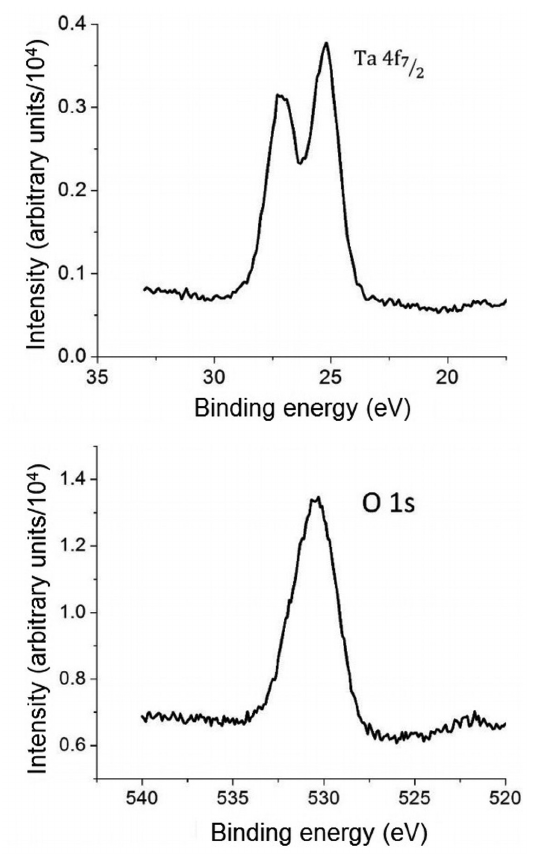
Figure 4. XPS spectra for tantalum and oxygen of the sample of tantalum oxide obtained in H